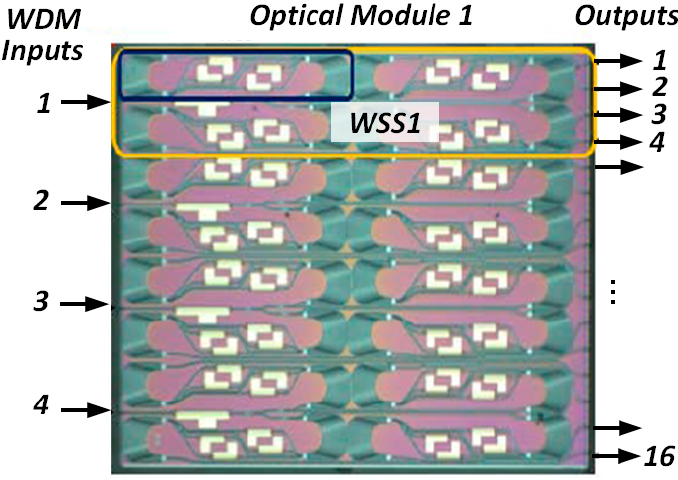
Figure 4. Schematic of the fabricated 4 × 4 fast optical switch PIC.